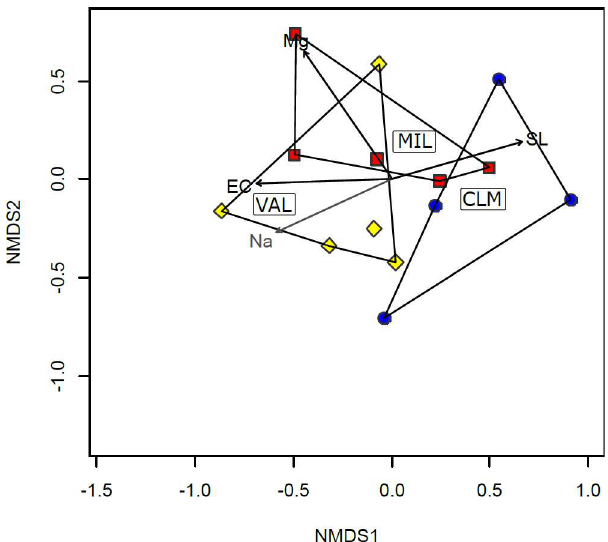
Fig 5. Joint plot of the NMDS ordination of the AMF communities colonizing the B . subacaulis roots in the different plots and the significance vectors(p < 0.1) of the environmental variables across the sites. The vectors graphicallyrepresent the correlationsof the NMDS axes to each of the measuredvariables of the soil. The length of the arrow is proportional to the strength of the correlationbetweenthe environmental variablesand community dissimilarities. Mg, availablemagnesium; Na, availablesodium; EC, electrical conductivity; SL, slope. Polygonshave been used to group the plots in the same site. Symbols: red, filled squares= MIL, Millefonts; blue,filled circles = CLM, Bassa di Colombart,and yellow, filled diamonds = VAL,